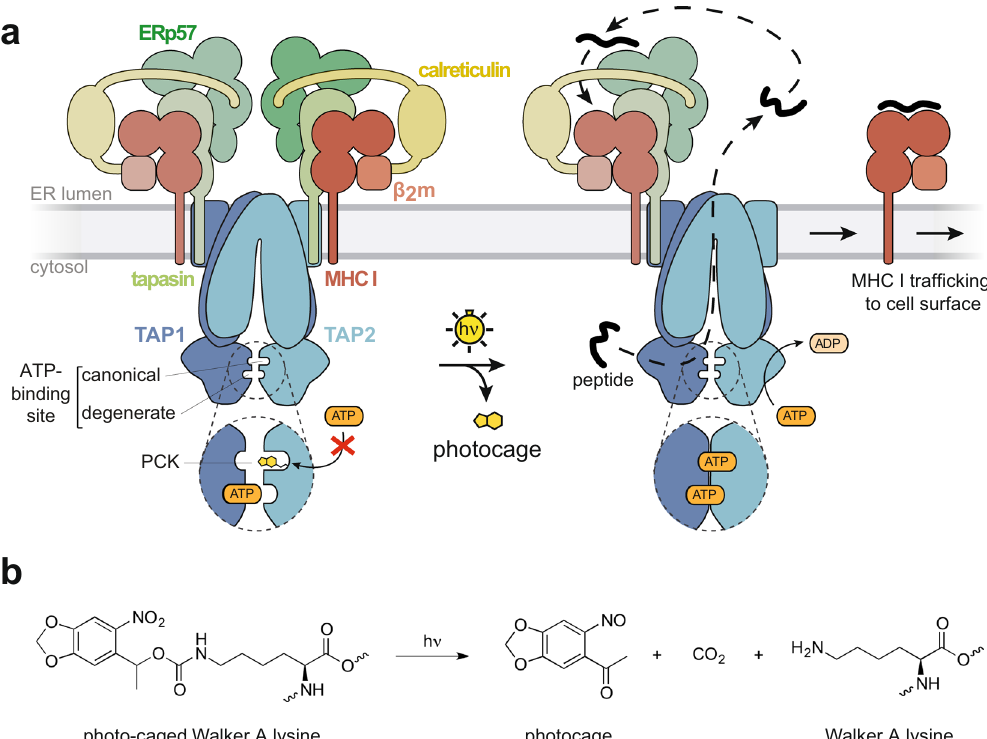
Fig. 1 Photo-conditional peptide loading complex. a The conserved lysine of the TAP2 Walker A motif, which is crucial for ATP binding and hydrolysis in the canonical ATP-binding site, is replaced by a photo-caged lysine (PCK) using amber suppression. TAP function is arrested due to the photocage that prevents ATP binding. After illumination and release of the photocage, TAP and PLC function is restored, which activates peptide translocation, MHC I loading and traf fi cking. b Illumination triggers the uncaging of PCK and allows restoration of the native lysine